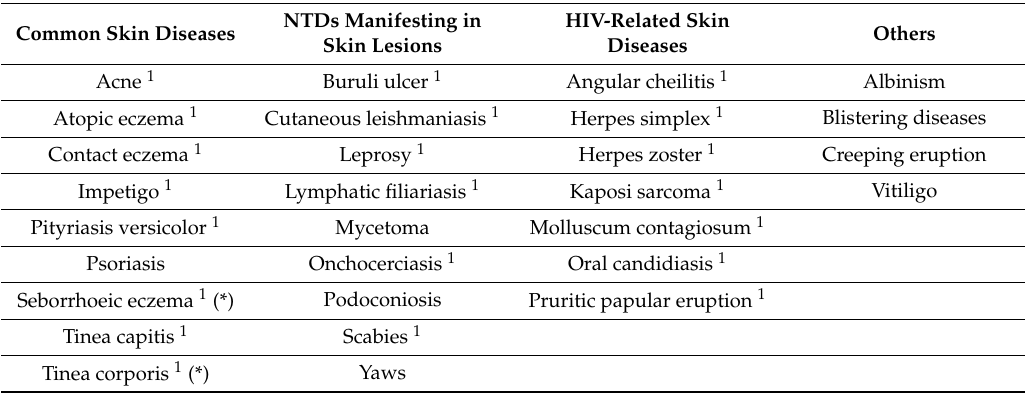
Table 1. Skin Diseases in The SkinApp. NTD: neglected tropical